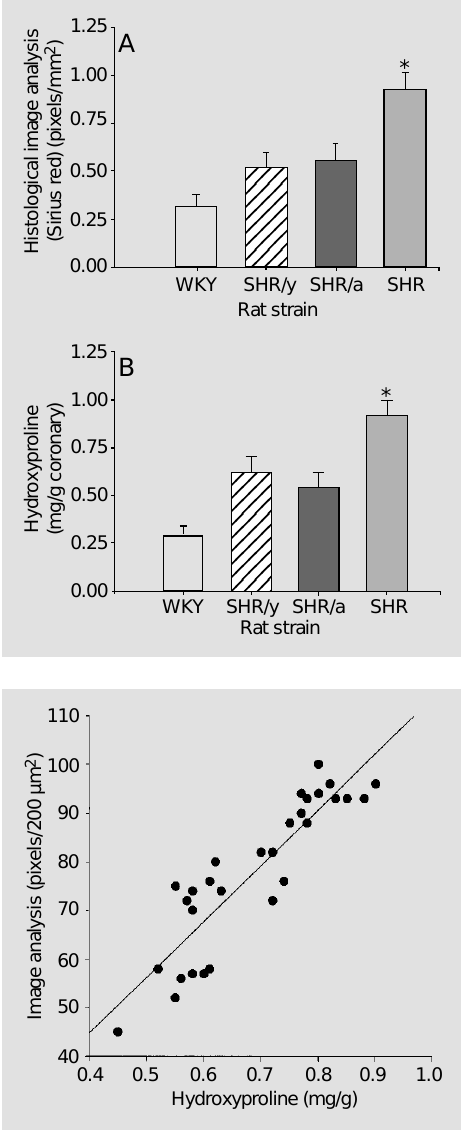
Table 1 - Blood pressure and coronary and ventricular collagen by rat strain (males, 20